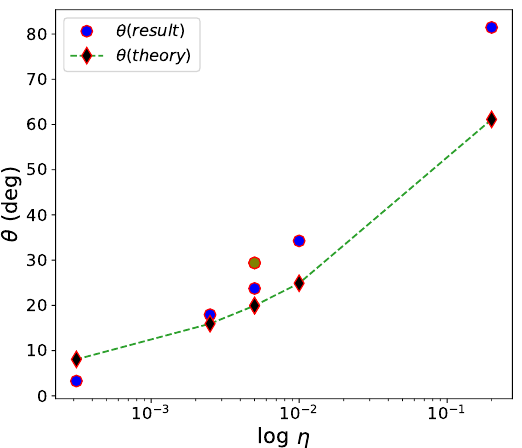
Figure 9. Wind semi-opening angle at time t = 150 days. We include the theoretical value according to Equation (2) (marked ‘theory’; black squares) and the simulations results (blue